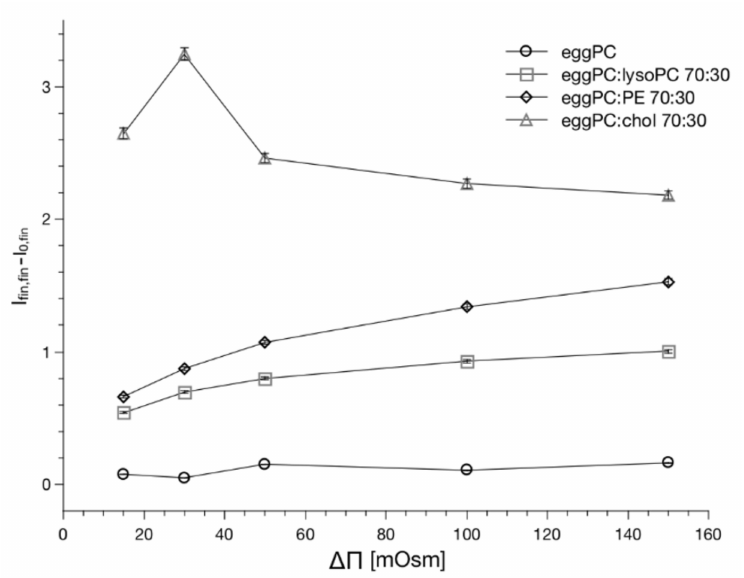
Figure 6. The effect of the osmotic pressure difference and lipid bilayer composition on the changes of the scattered light intensities induced by the water outflow from